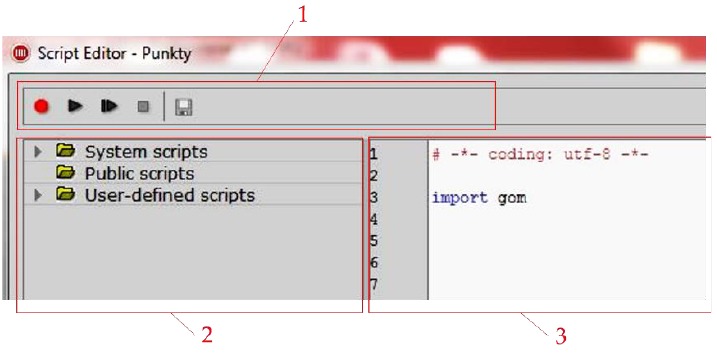
Figure 8. Creating scripts in Atos Professional.